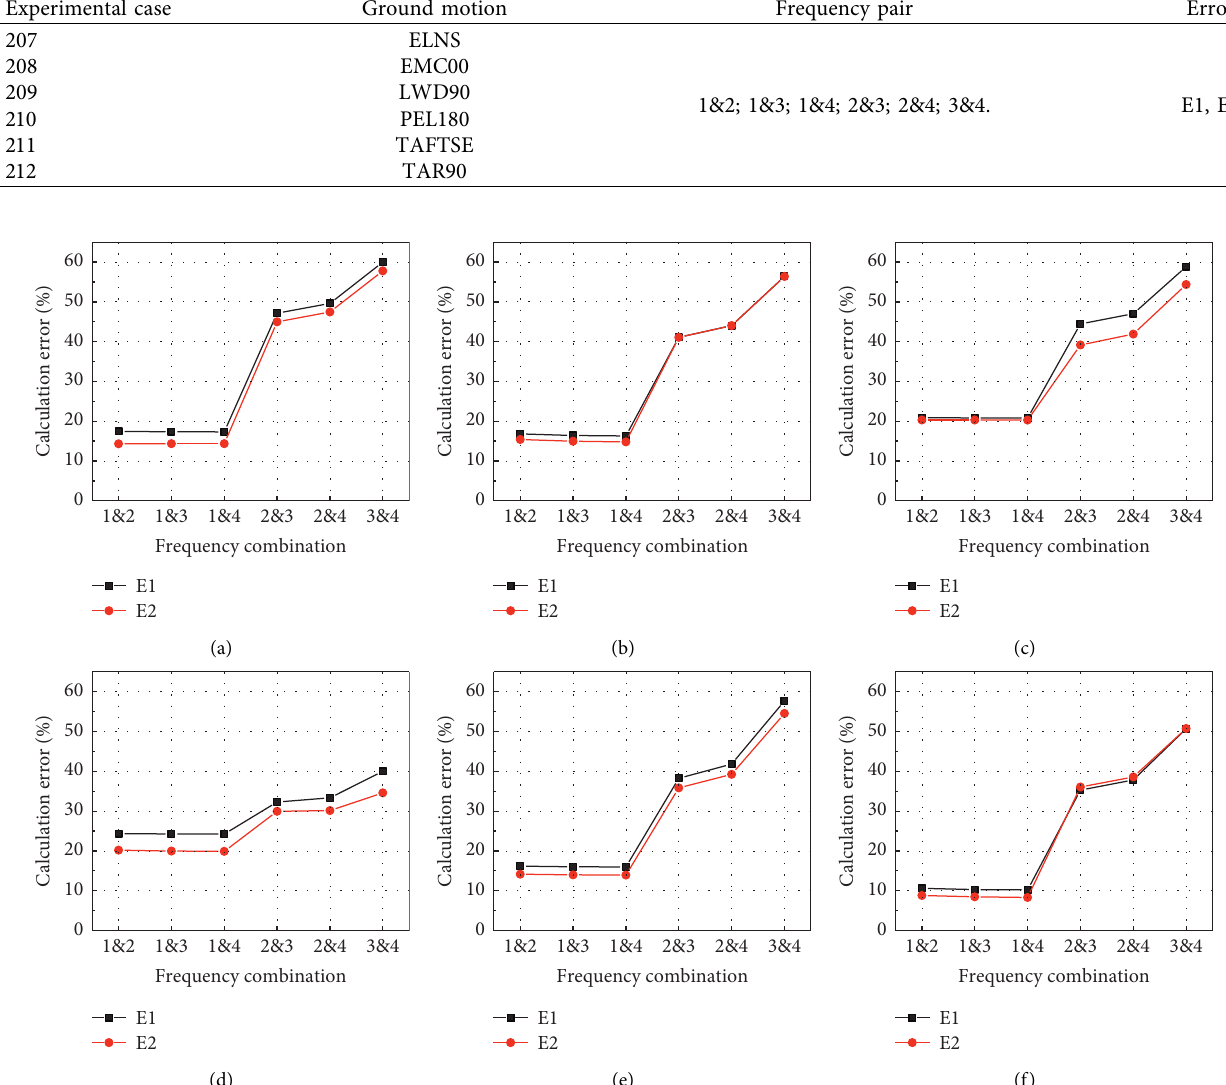
Figure 4: Calculation error of isolation displacement by using RD (PGA � 0.07 g): (a) case 207, (b) case 208, (c) case 209, (d) case 210, (e) case 211, and (f) case